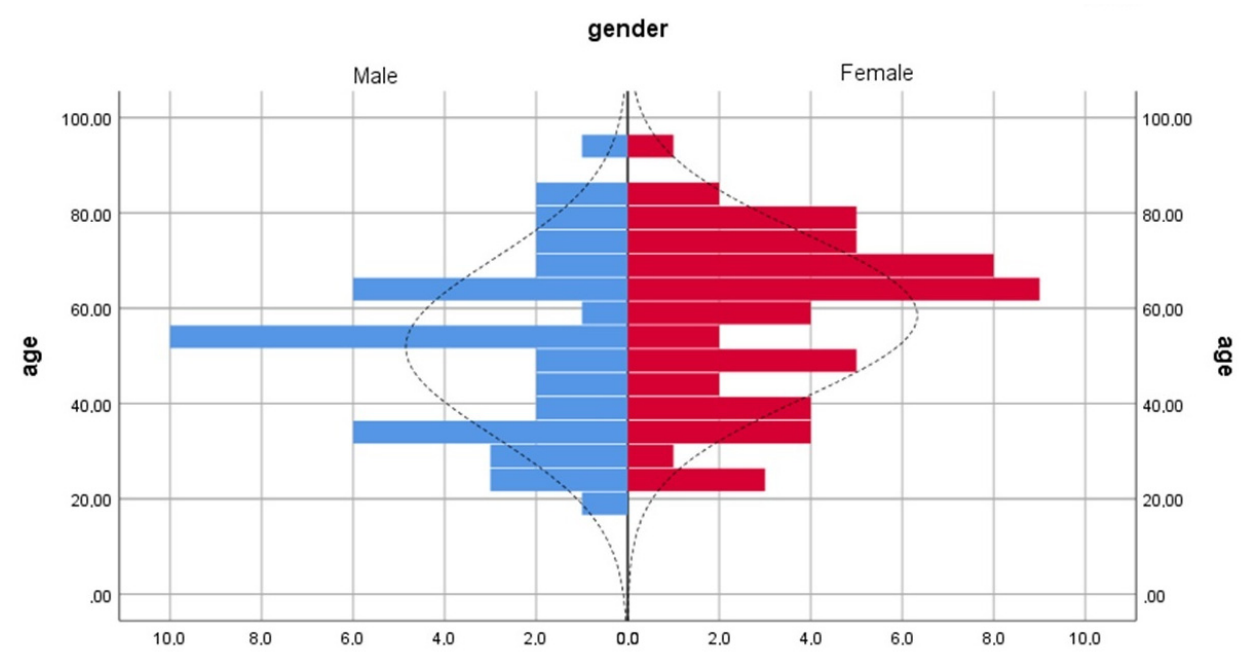
Figure 1. Distribution according to gender of the group.